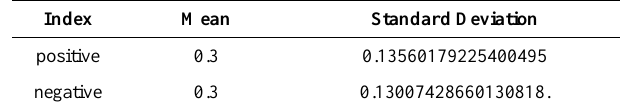
Table 6. Index, mean and standard deviation for positive and negative index